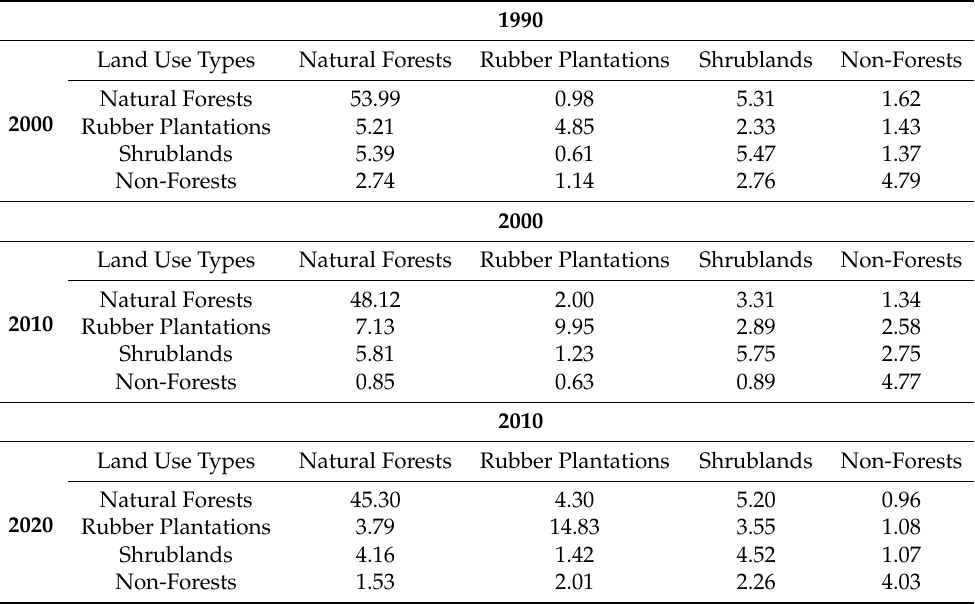
Table 4. Land use/land cover transfer matrix in Xishuangbanna in 1990, 2000, 2010, 2020